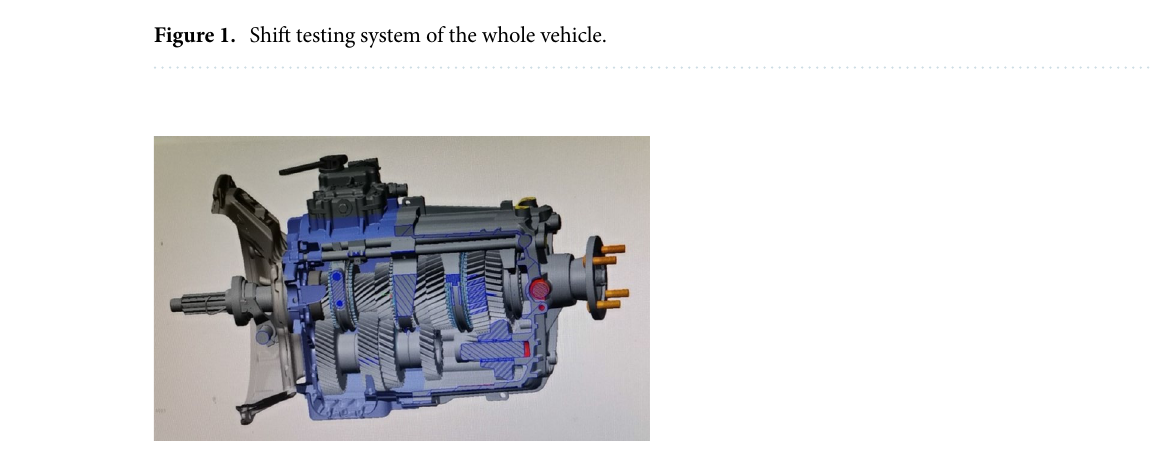
Figure 2. Schematic diagram of the analyzed